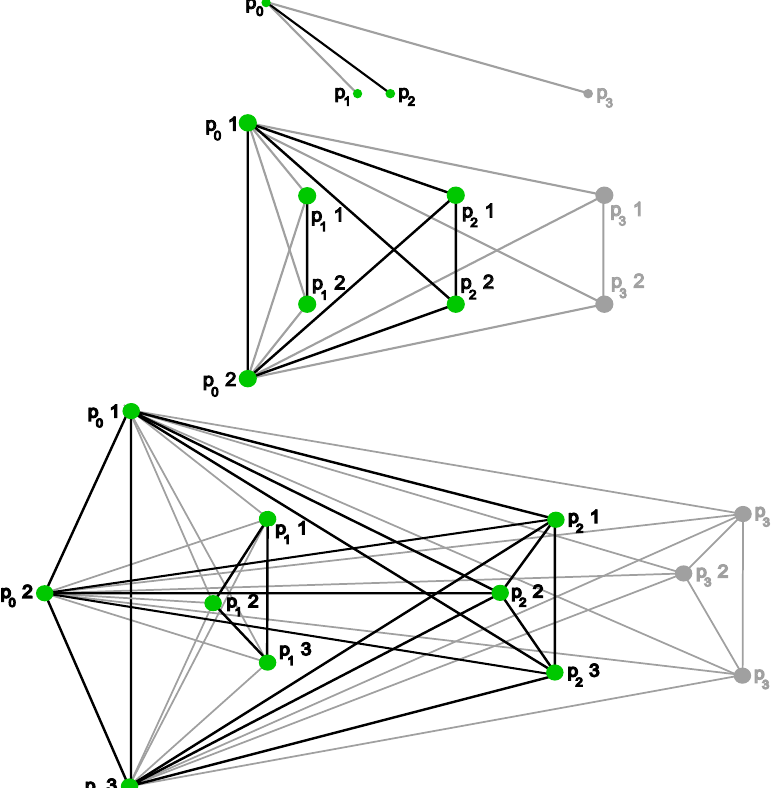
Figure 3. From the top: the inclusion of poset H ( 5 ) into poset H ( ∞ ) of Figure 2, the image under T 2 , and the image under T 3 (Definition